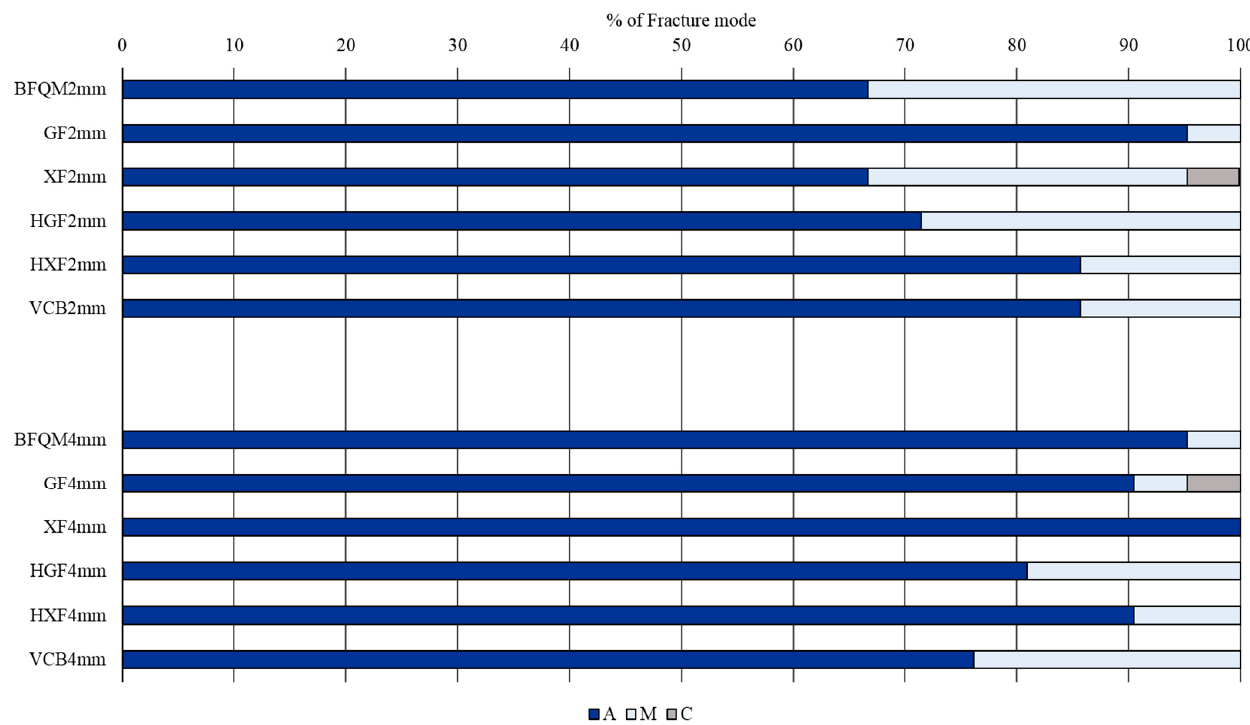
Figure 3. Percentages of fracture mode analysis within each CAD/CAM thickness and resin composite. A: Adhesive, M: Mixed, and C: Cohesive.